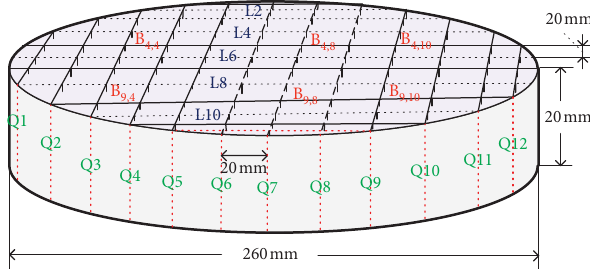
Figure 16: Sampling slice acquisition.